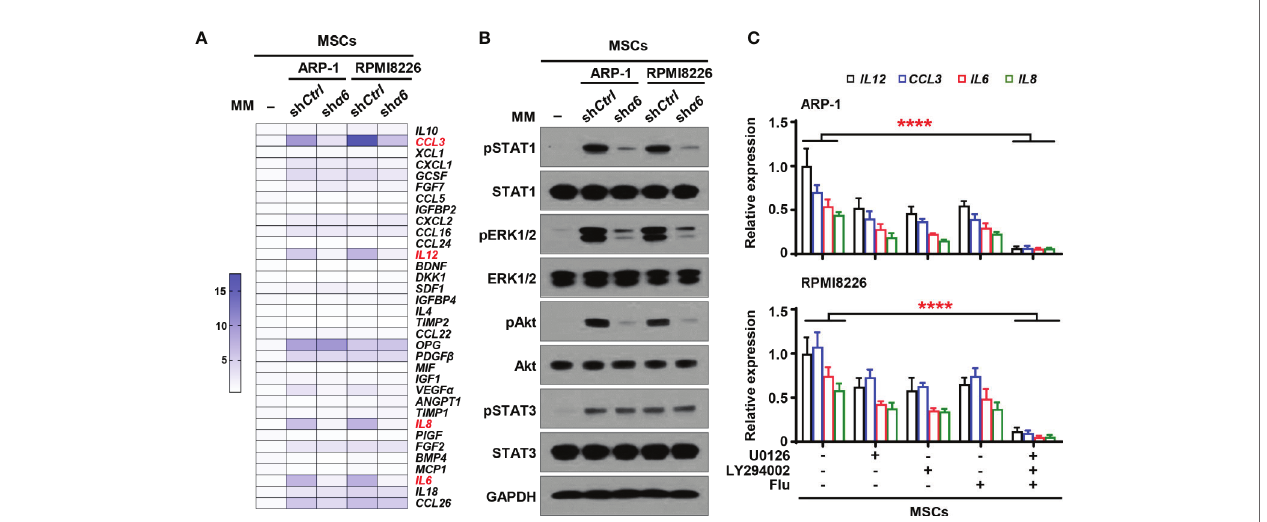
FIGURE 4 | Myeloma cell integrin a 6 regulates cytokine expression via Akt, ERK, and STAT1 signaling pathways in MSCs. MSCs were cocultured with or without myeloma cell lines ARP-1 or RPMI 8226 carrying nontargeted shRNA ( shCtrl ) or ITGA6 shRNA ( sh a 6 ) for 24 hours. (A) Quantitative real-time PCR analysis shows the relative expression of cytokine genes in MSCs. (B) Western blotting shows phosphorylated (p), or non-phosphorylated ERK1/2, Akt, STAT1 and STAT3 in MSCs. GAPDH levels served as protein loading controls. Representative images are shown from three independent experiments. (C) The relative expression of IL12 , CCL3 , IL6 and IL8 mRNAs in MSCs co-cultured with ARP-1 (Upper panel) or RPMI8226 (Lower panel) in the absence or presence of the STAT1 inhibitor Fludarabine (10 µM), ERK inhibitor U0126 (5 µM) or Akt inhibitor LY294002 (10 µM). Data shown as averages ± SD is a representative of three independent experiments. **** P < 0.0001. All P values were determined using one-way ANOVA.